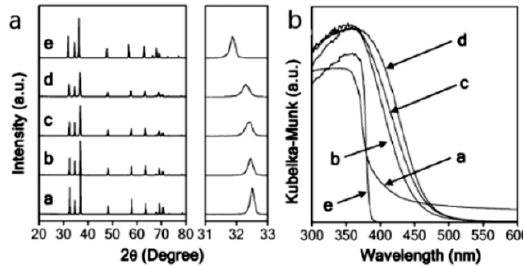
Figure 5. ( a ) Power X-ray diffraction pattern and ( b ) ultraviolet light visible diffuse reflectance spectra: a, b, c, d, e stand for GaN (ref), GaN:ZnO (Zn 3.4 at. %), GaN:ZnO (Zn 6.4 at. %), GaN:ZnO (Zn 13.3 at. %), and ZnO. Reprinted with permission from ref. [18]. Copyright 2018. American Chemical Society.